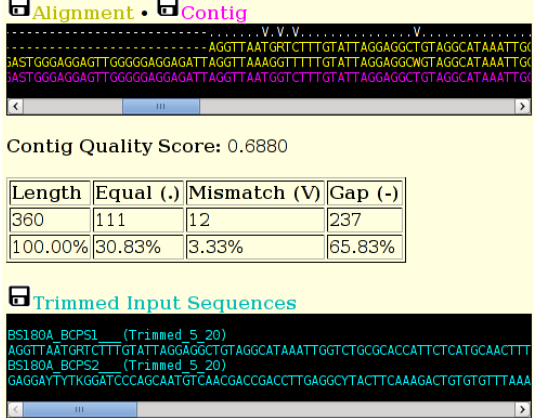
Figure 3. A section of the output of the ACGT tool, showing the indicator line (top) in white, the two trimmed and aligned sequences (yellow) and the computed consensus sequence (magenta). The table displays totals of the various consensus groups. The trimmed sequences are displayed in cyan. Sequences can be downloaded in FASTA format by selecting the small black disk